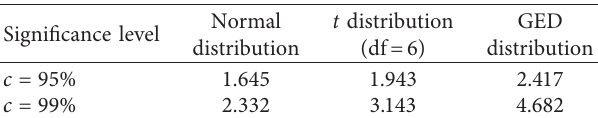
Table 6: Quantile